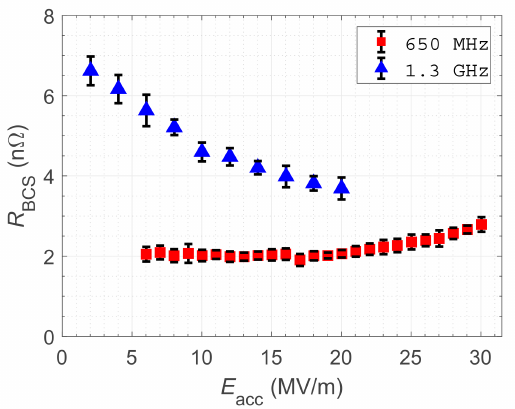
Figure 5. BCS resistance ( R BCS ) of 650 MHz cavity and 1.3 GHz cavity (at 2.0 K), which both received mid-T furnace baking.